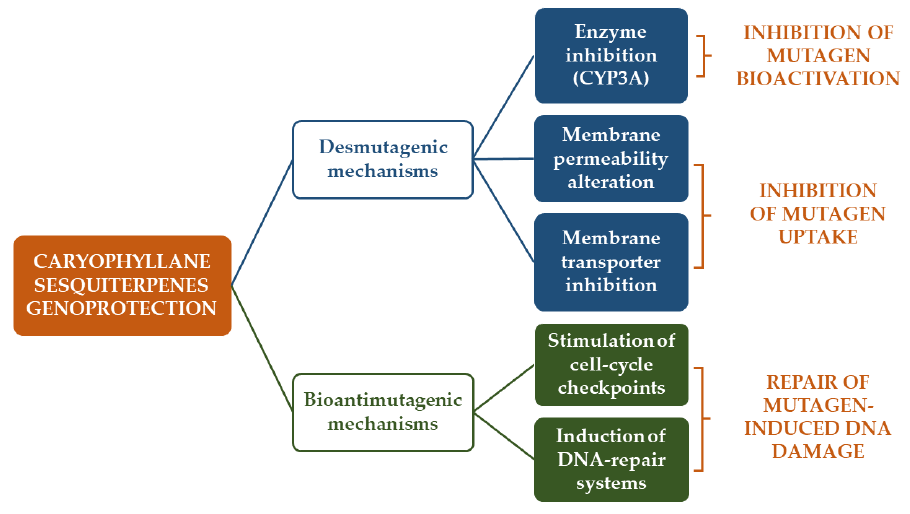
Figure 6. Mechanisms accounting for the genoprotective properties of β-caryophyllene and β- caryophyllene oxide